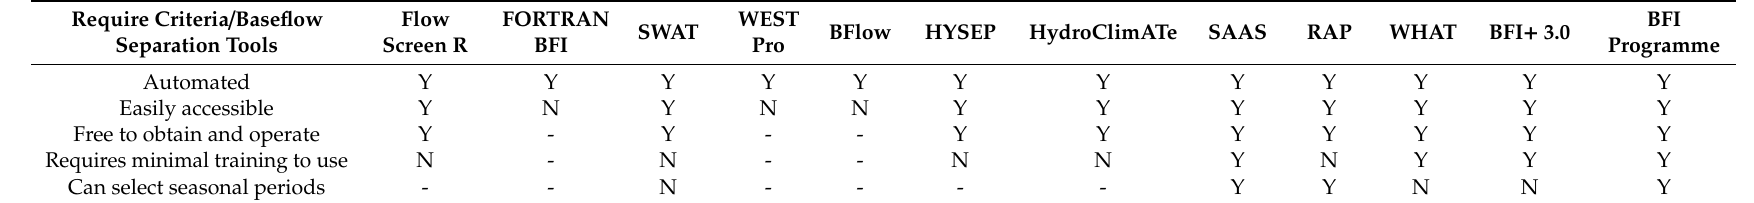
Table 1. Evaluation of baseflow separation tools against required